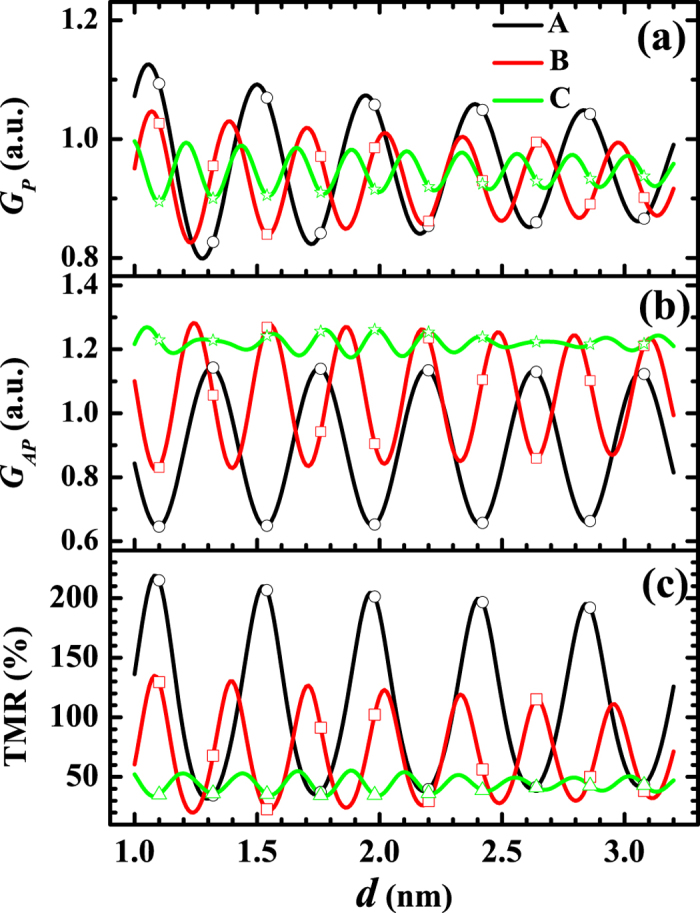
Thickness dependence of GP, GAP and TMR with the variation of v(Kh).(a) GP, (b) GAP and (c) TMR as functions of barrier thickness d where Kh = 2.116 × 1010 m−1, μ = 11 eV and Δ = 10 eV. The curves A, B, and C correspond to v(Kh) = 12 eV, 16 eV and 20 eV, respectively. The data corresponding to the discrete layers of the grating barrier are marked with open symbols: curve A is marked by open circle, curve B is marked by open square, and curve C is marked by open triangle.